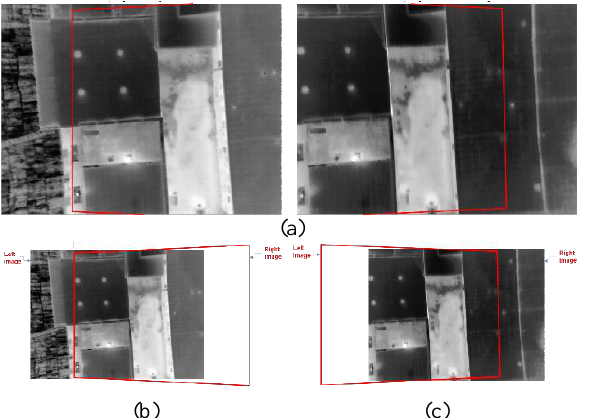
Figure 4: Matching region of neighbouring images in (a). (b) and (c) show left and right image overlapped by the homographic projected bonding box of its corresponding matching image,